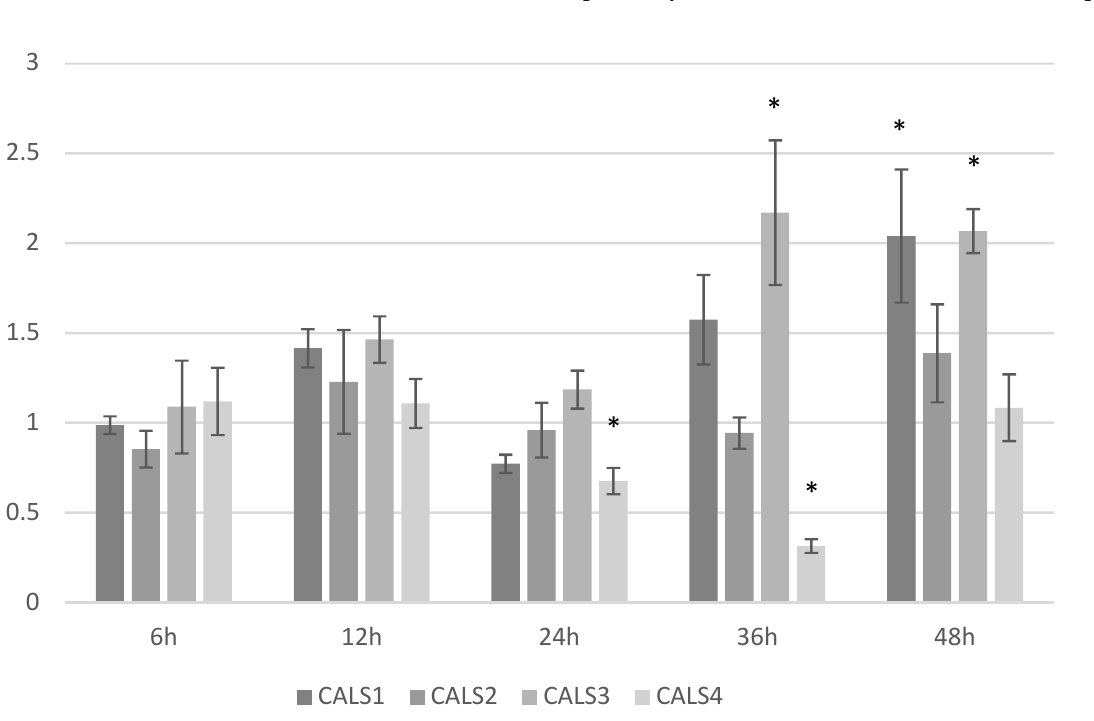
Figure 5. Transcript levels of callose synthase genes ( CALS1 , CALS2 , CALS3 , CALS4 ) in flax seedlings treated with F. culmorum measured at five timepoints after the infection. Results are presented as a fold of the control (means of three biological repeats ± sd). Statistically significant changes are marked with asterisks.